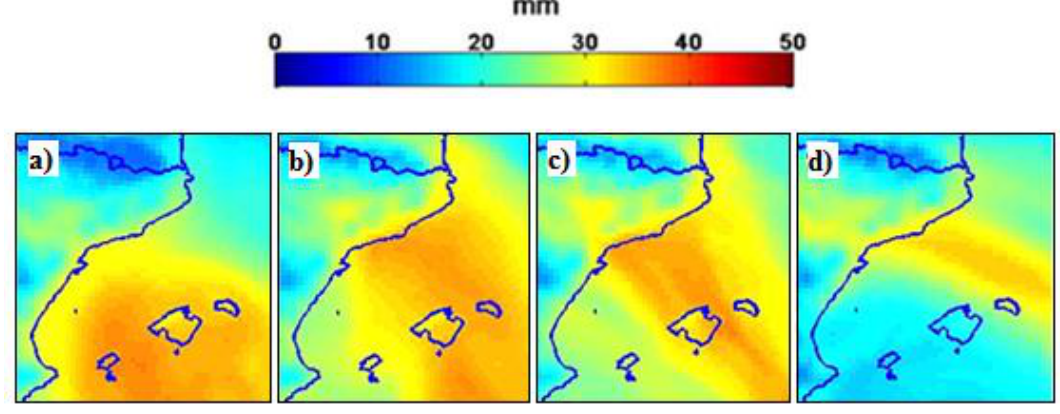
Fig. 10. Columnar water vapor predicted by MM5 during the episode, where each image corresponds to the nearest hourly model output to the satellite passes: (a) 02:00 UTC 9 May, (b) 14:00 UTC 9 May, (c) 01:00 UTC 10 May, and (d) 13:00 UTC 10 May. Figure 10. Columnar water vapor predicted by MM5 during the episode, where each 3 image corresponds to the nearest hourly model output to the satellite passes (a) 02UTC 4 9 May, b) 14UTC 9 May, c) 01UTC 10 May, and d) 13UTC 10 May). 5